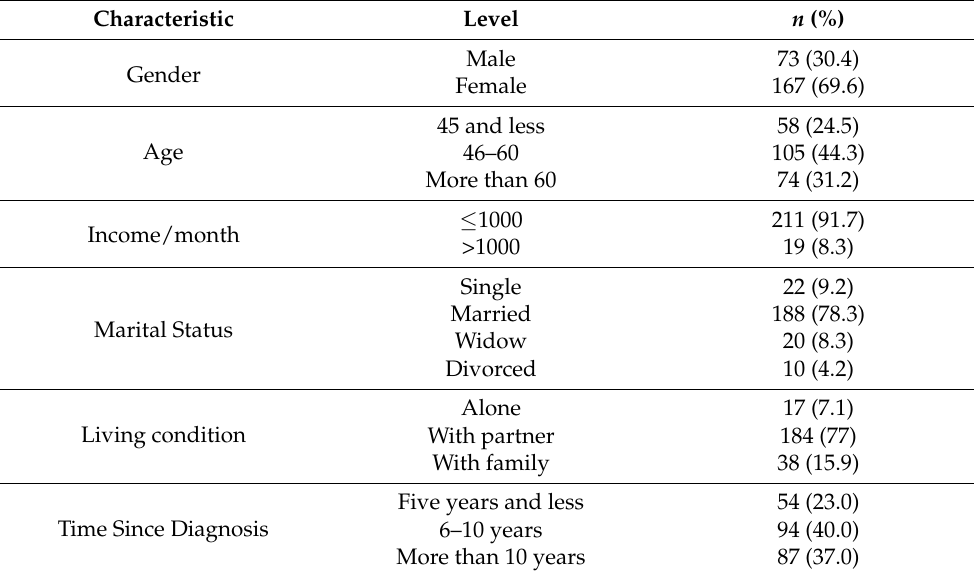
Table 1. Characteristics of study participants, n =